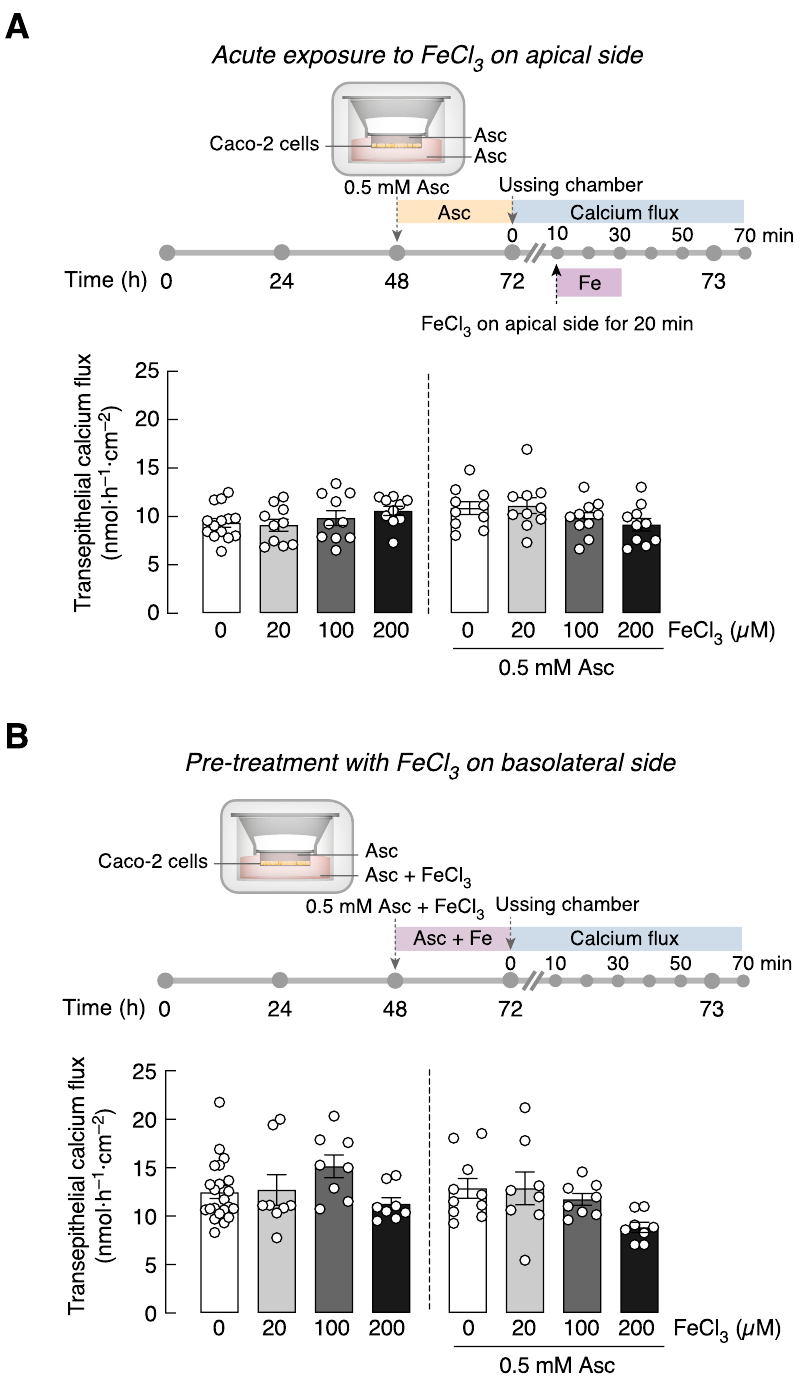
Fig 5. Acute and long-term effects of FeCl 3 exposure on calcium transport in Caco-2 monolayer pre-treated with ascorbic acid (Asc). (A) Transepithelial calcium transport across Caco-2 monolayers with or without 0.5 mM Asc pre- treatment and acute exposure with different doses of FeCl 3 (i.e., 0, 20, 100, 200 μ M) on apical side. (B) Transepithelial calcium transport across Caco-2 monolayers with or without 0.5 mM Asc with different doses of FeCl 3 (i.e., 0, 20, 100, 200 μ M) pre-treatment on basolateral sides (n =